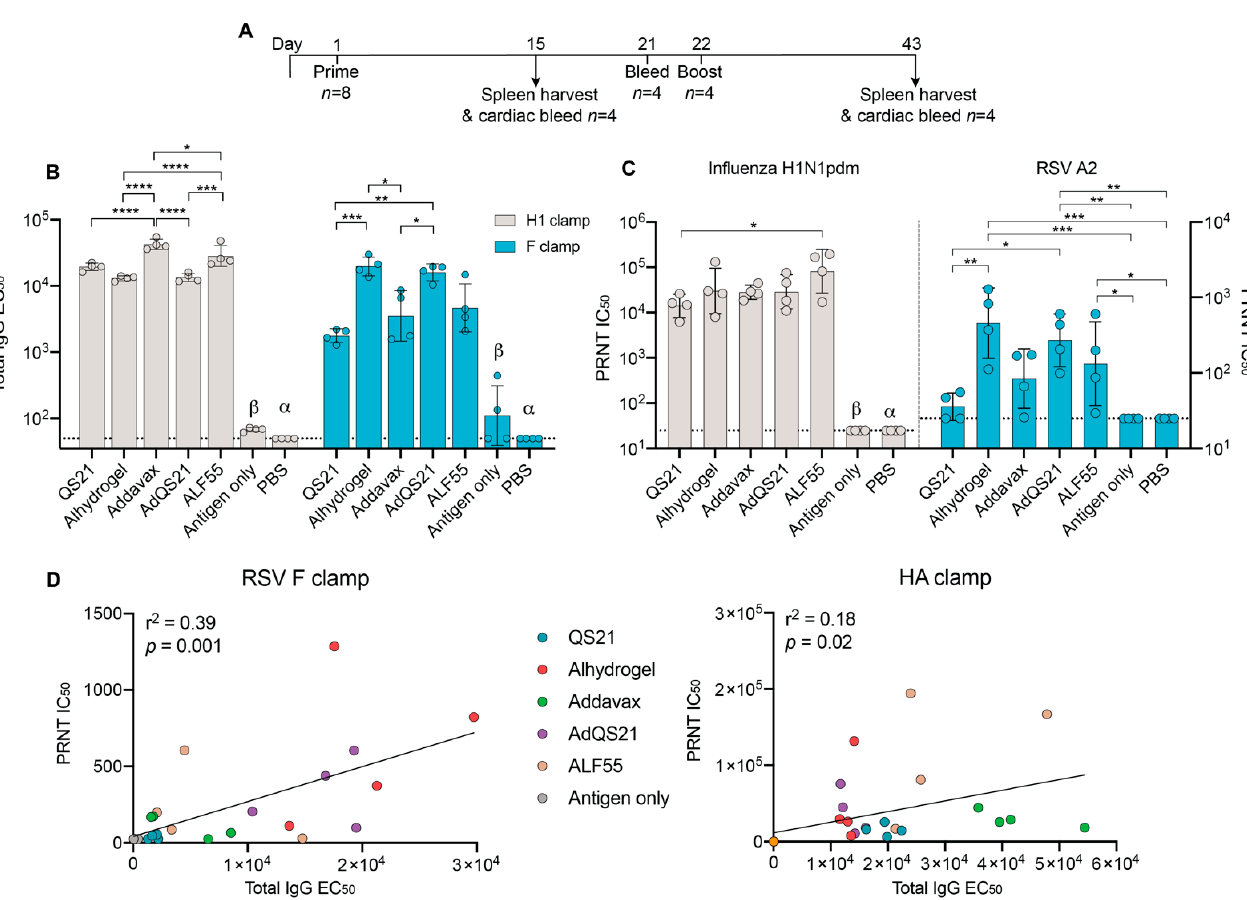
Figure 1. Serum analysis of terminal bleed from mice immunized with clamped antigen with different adjuvants. ( A ) Schematic of immunization regime. ( B ) ELISA EC 50 of serum against each vaccine antigen on day 43. Dotted line shows limit of detection. ( C ) Serum samples from final cardiac bleed (day 43) tested against homologous H1N1pdm (A/Auckland/1/2009, left) virus or respiratory syncytial virus (RSV) A2 (right) in a plaque reduction neutralization test (PRNT). Data represents geometric mean ( n = 4) with geometric standard deviation (SD). Dotted line shows limit of detection. p -values were calculated using a one-way Tukey’s multiple comparison ANOVA, where * indicates p < 0.05, ** p < 0.005, *** p < 0.0005, and **** p < 0.0001; β = p < 0.0001 compared to all groups except PBS, and α = p < 0.0001 compared to all groups unless otherwise specified. ( D ) Linear regressions of PRNT IC 50 vs. total IgG EC 50 from groups vaccinated with RSV fusion (F) clamp (left) and haemagglutinin (HA) clamp (right).